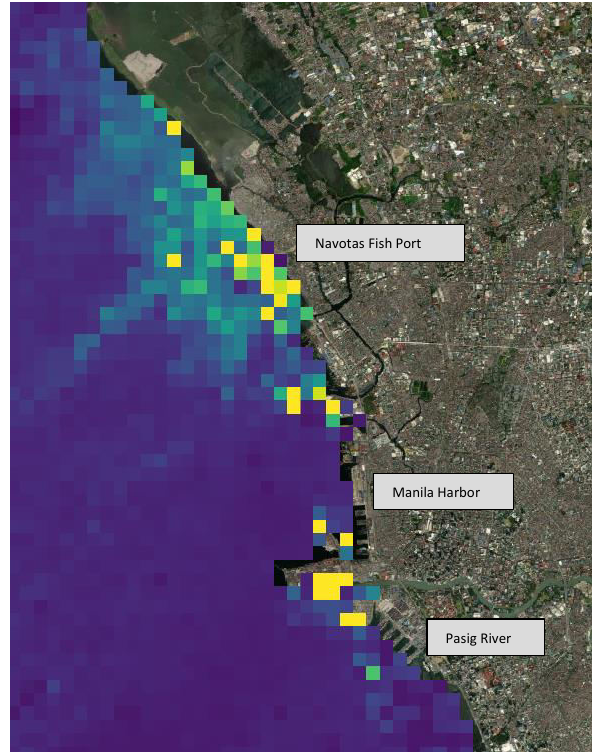
Figure 9 . High CDOM areas near Manila Harbor, Navotas Fish Port and Pasig